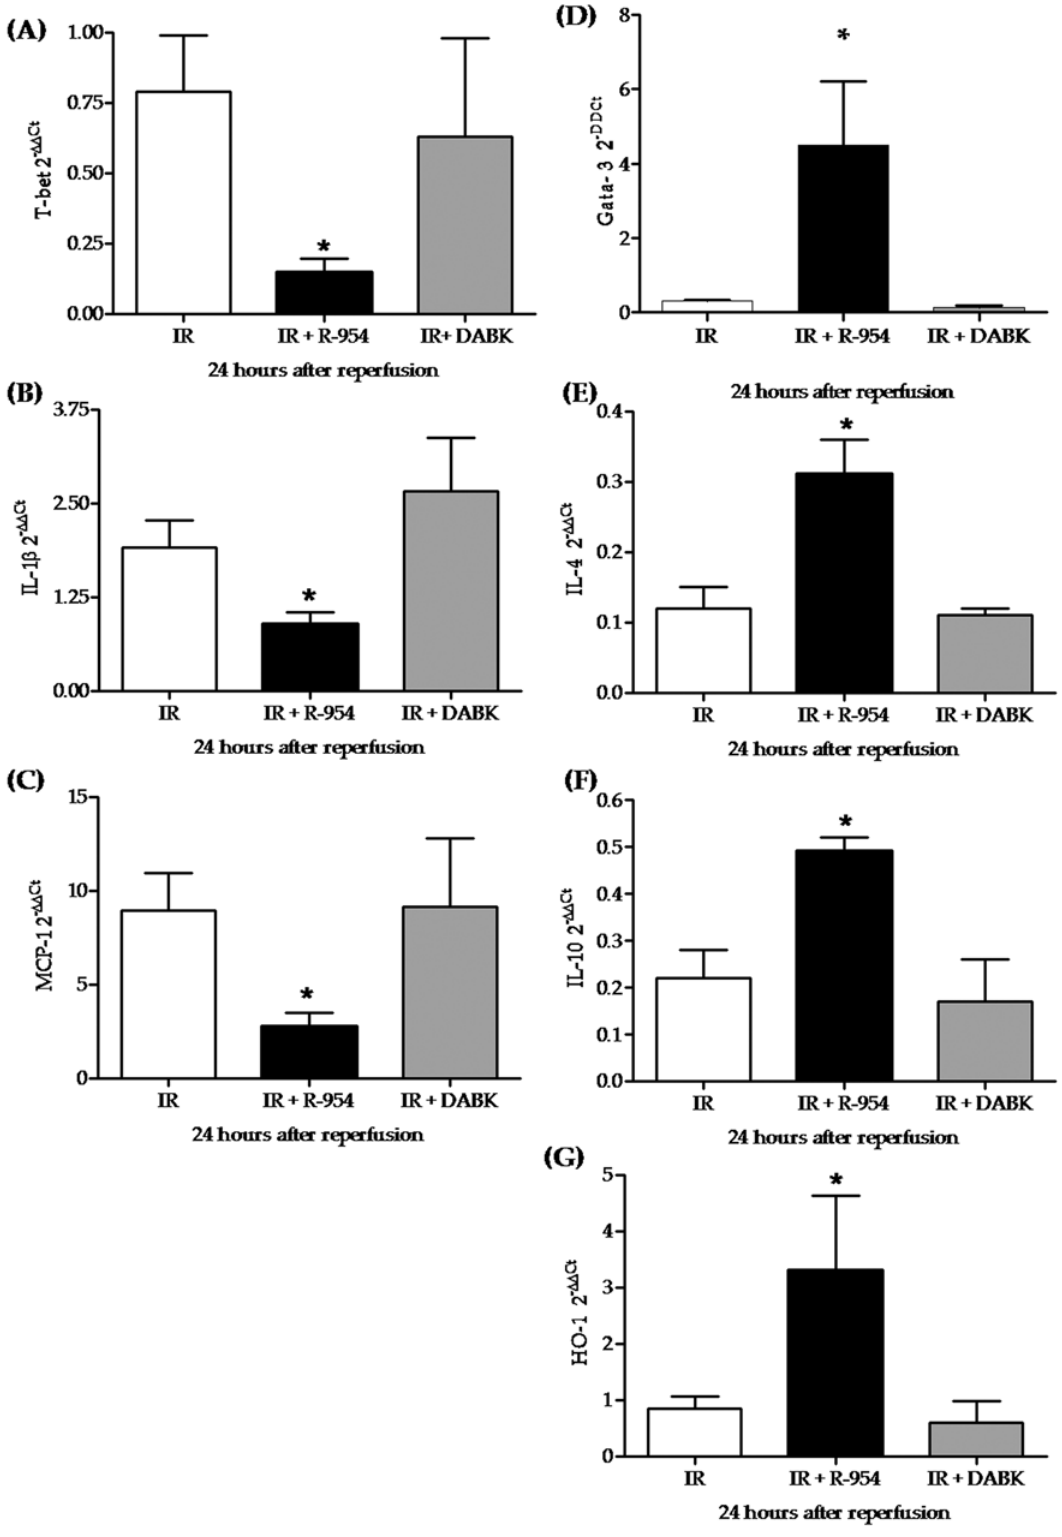
Figure 5. Pro and anti-inflammatory molecules expression after B1R antagonist and agonist treatment. All molecule expressions were estimated by real-time PCR at 24 hours of reperfusion. B1R antagonism (R-954) resulted in lower pro-inflammatory molecule expression (T-bet, IL-1 b and MCP-1) (A, B and C) and higher anti-inflammatory response (GATA-3, IL-4, IL-10 and HO-1) (D, E, F and G). Molecule expression after B1R agonism (DABK) were similar to non-treated mice. Statistical analyses were performed using ANOVA.*IR + HOE-140 versus IR, p , 0.05.